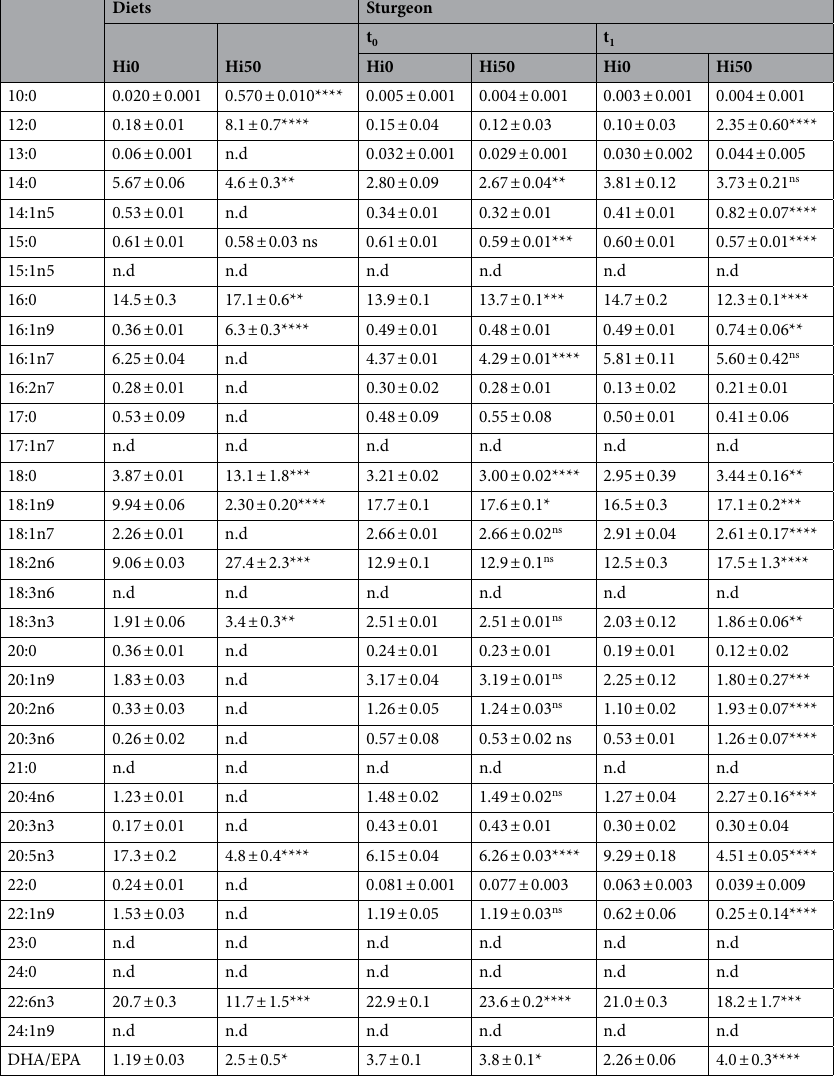
Table 1. Fatty acid composition (as % of total FA) of experimental diets and Siberian sturgeon at t 0 and t 1 . Experimental diets included 0 and 50% of BSF meal respect to FM (Hi0 and Hi50). Siberian sturgeon fed diets including 0 and 50% of BSF meal (Hi0 and Hi50). Significant differences between Hi0 and Hi50 within rows and separately from diets,